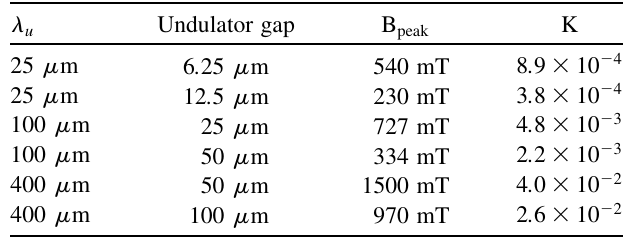
TABLE I. Optimized undulator geometries using Design 2. (cid:2) u